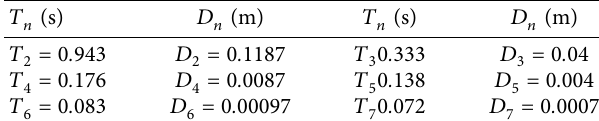
Table 9: Elastic periods and higher modes responses.